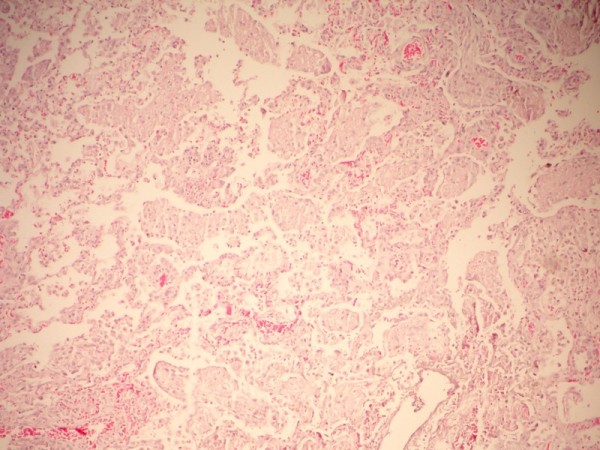
Histopathological changes on the 5. day in the lung in which Ankaferd was applied. Newly organized fibrin plugs are observed in the alveoli of the lung of Ankaferd-applied rats( H&E, X200)